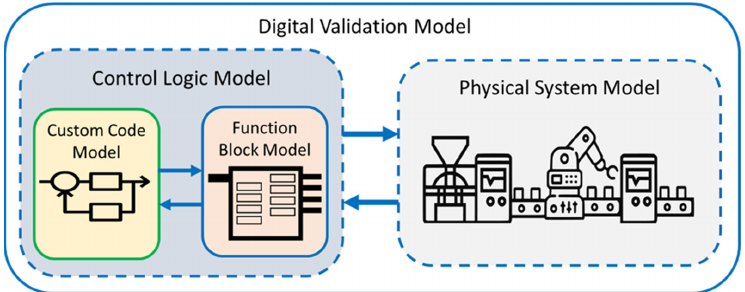
Figure 4. Digital validation modelling architecture.